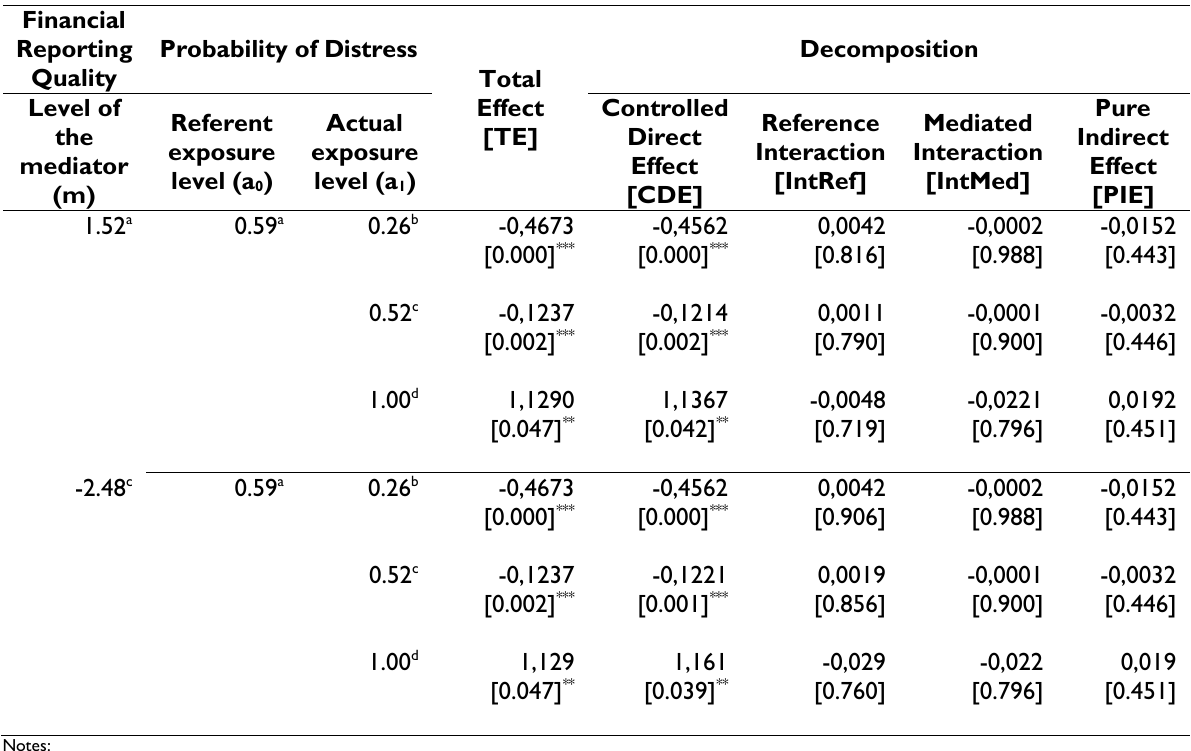
Table 7. The Decomposition of the Effect of Financial Distress on Financial Reporting Delay and Financial Reporting Quality as a